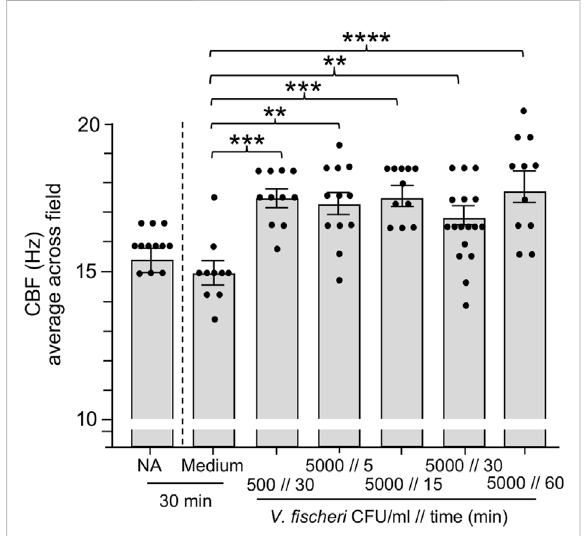
FIGURE 4 Ciliary beat frequency (CBF) measurements of hatchling light organs show exquisite sensitivity to Vibrio fi scheri . Animals were incubated with various concentrations of V. fi scheri ( Vf ) in natural seawater containing ~10 6 CFU/ml of other marine bacteria. As controls, animals were also exposed to only natural seawater with no additions (NA) or to addition of the same volume of cell- free0.22 µm- fi lteredspentLBS-mediumaspresentedwith Vf cells (Medium).A one-way ANOVA andTukey ’ s posthoc testwereused (F 6, 79 = 6.251, p < 0.0001). Animals ( n ) per treatment: NA, n = 12; medium control, n =10;medium with500 CFU/mlfor30 min, n